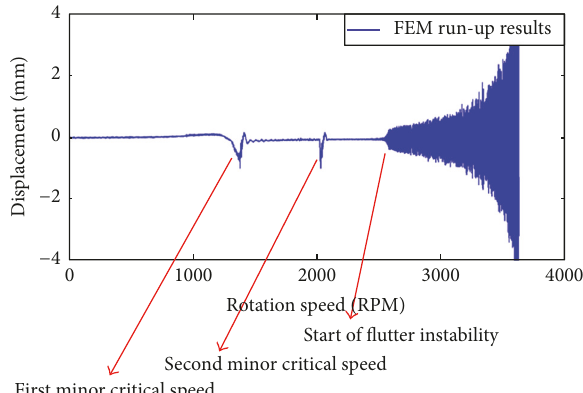
Figure 13: Deflection of the disk, during run-up, computed at outer radius, with angular position of 90 ∘